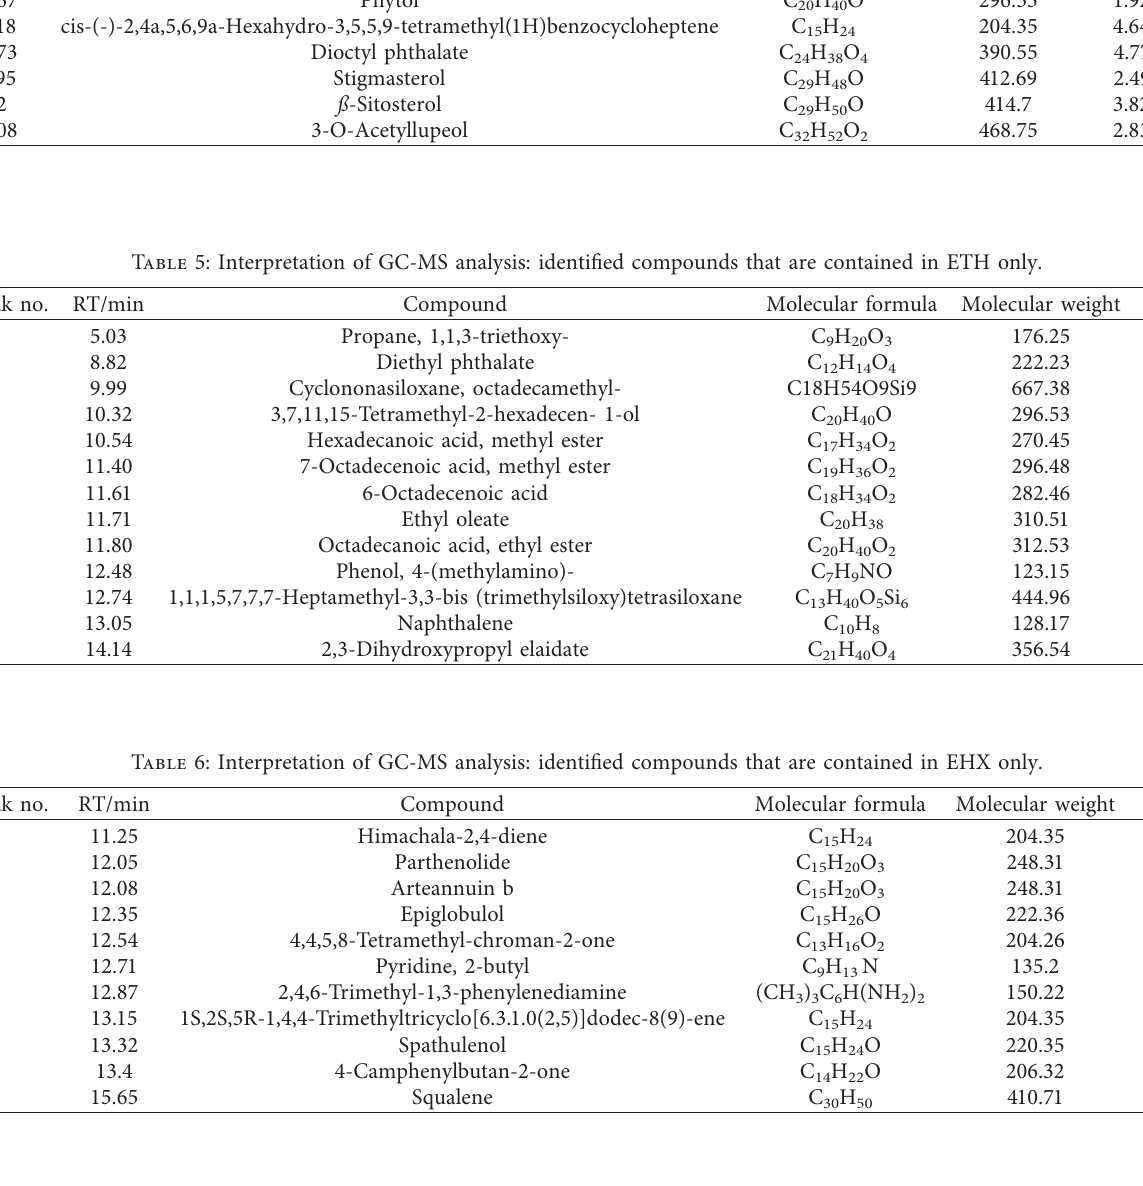
Table 7: Antioxidant activity of ETH extract and its fraction